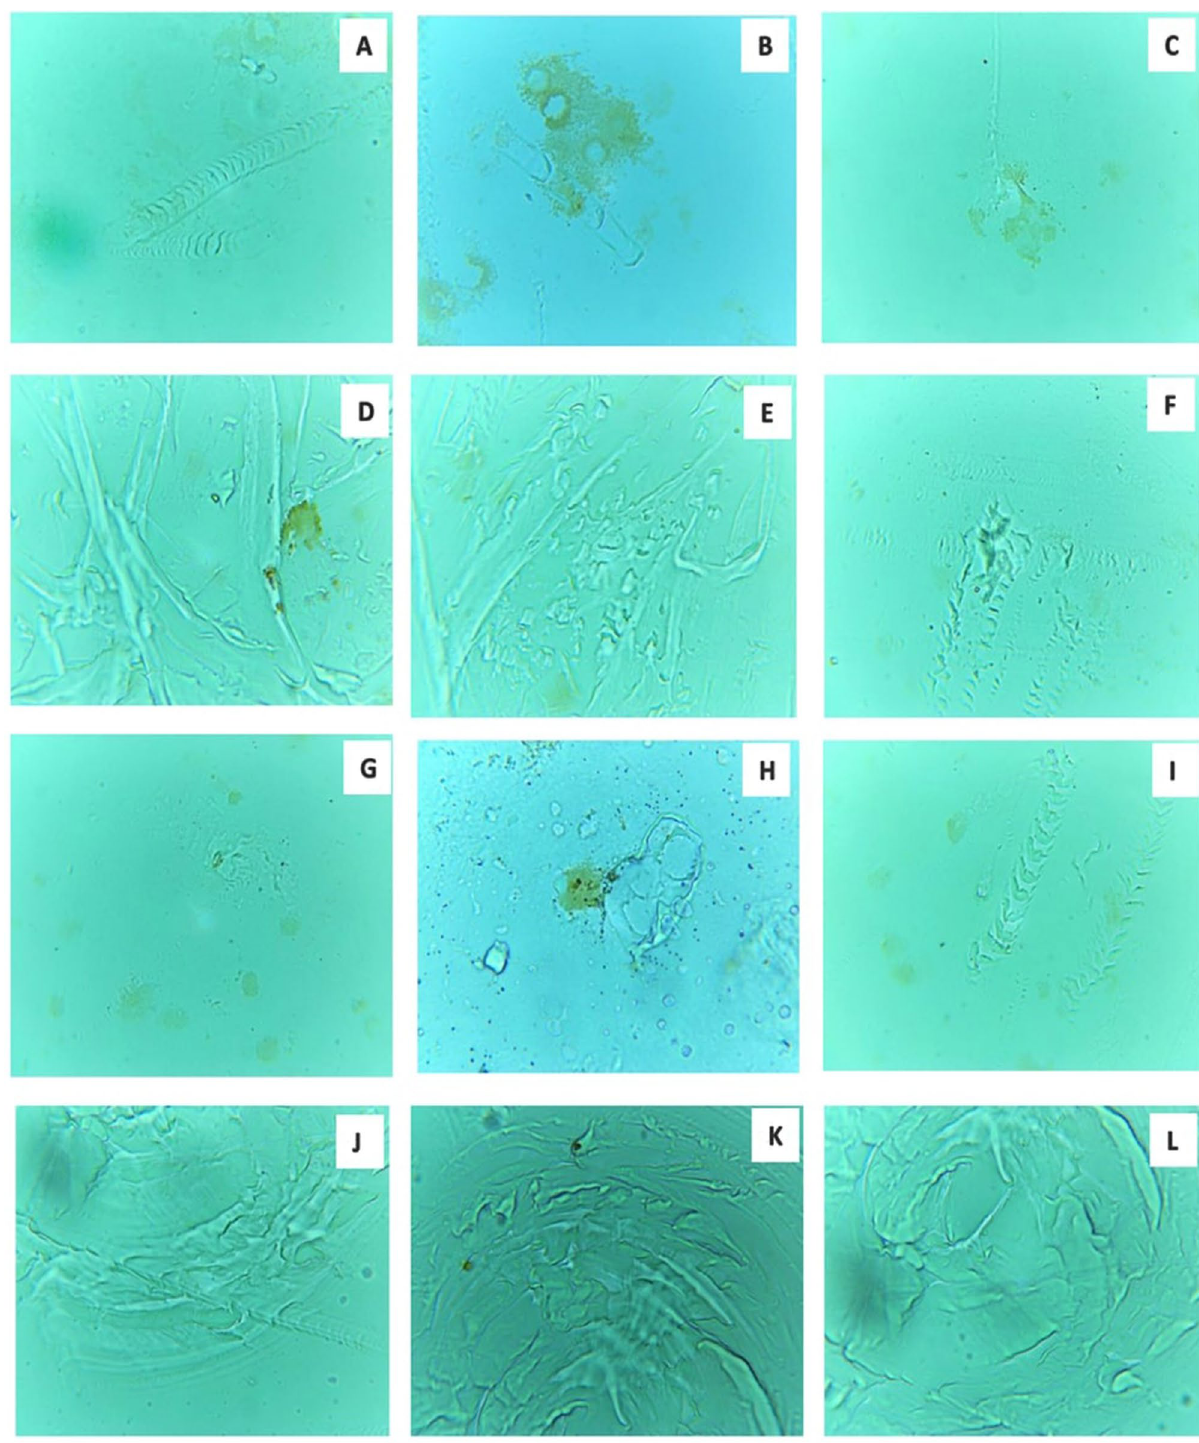
Figure 11. ( A – L ) Showing degraded surface of LDPE sheet by the microalga U. africanum (× 100 magnification) with erosions, abrasion and ridges and grooves on LDPE